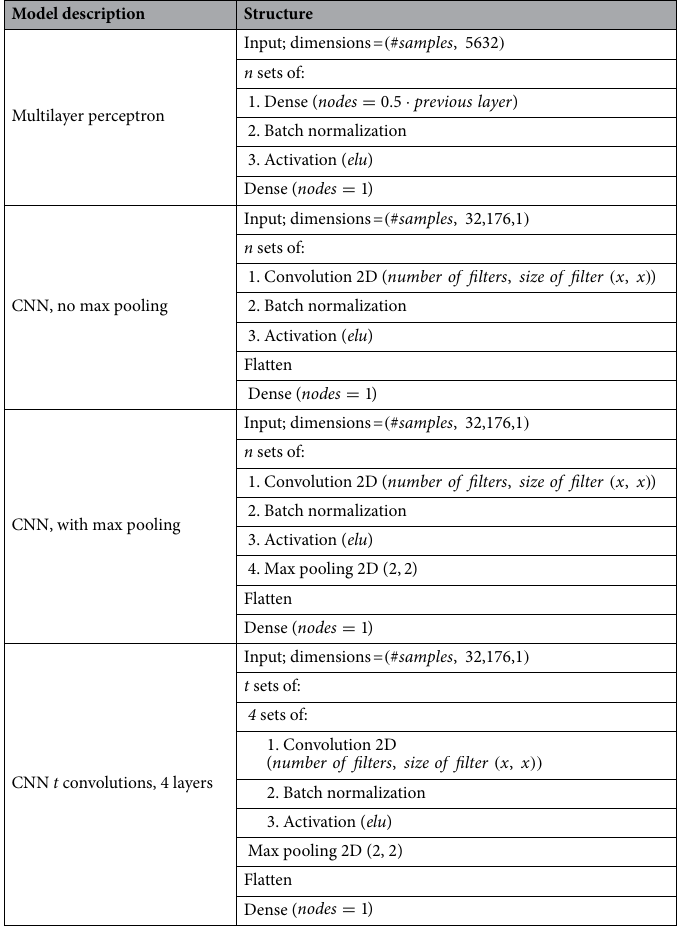
Table 2. Descriptions of the general model types used. n refers to the number of layers and is varied based on model depth.